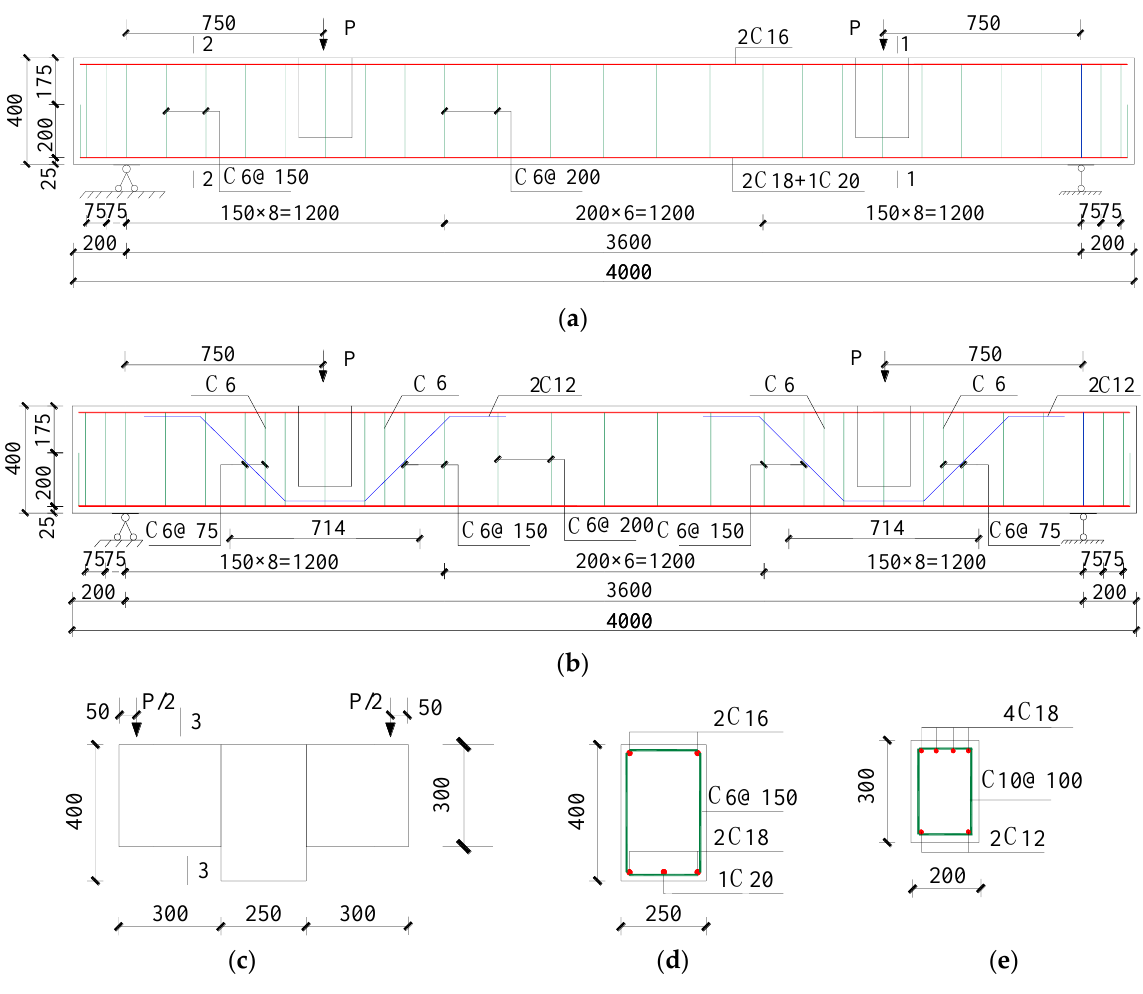
Figure 2. Schematic diagram of beams under indirect loading (dimension in mm). ( a ) Specimens CWJJL1, JJLH1, and JJLH2. ( b ) Specimens CWJJL2, JJLH3, and JJLH4. ( c ) Loading of secondary beams. ( d ) Primary beam. ( e ) Secondary beam.